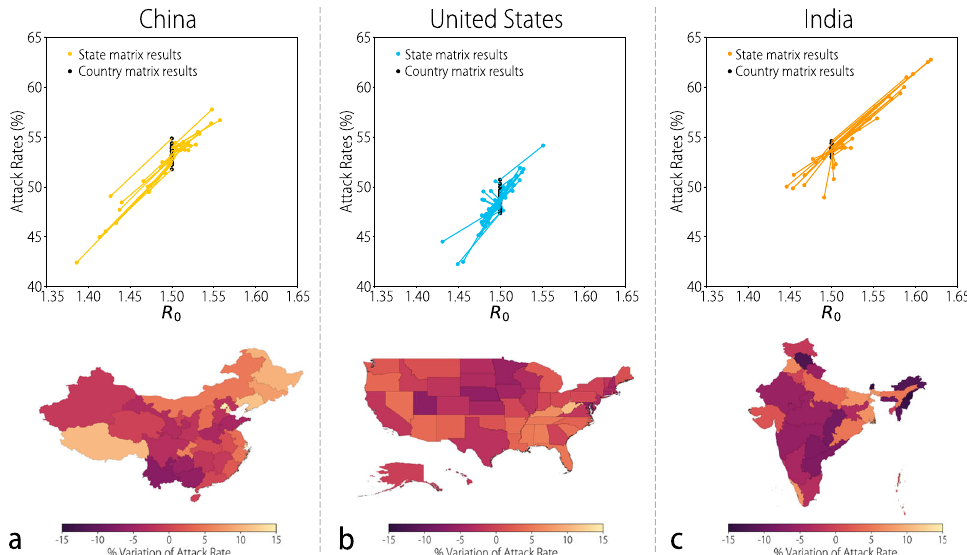
Fig. 7 Subnational heterogeneity. a The black dots represent the estimated attack rates in each province of China by using the country-level contact matrix and the location-speci fi c age structure of the population. Colored dots represent the estimated attack rates in each location by using both the location- speci fi c contact matrix and the age structure of the population. The colored lines connect the two estimated values of attack rate for each location. The transmission rate is set such that R 0 = 1.5 when using the country-level matrix. Each map shows the percentage variation of the attack rate using the location-speci fi c contact matrix with respect to using the national contact matrix as a proxy for the subnational contact patterns (i.e., (AR c − AR l )/AR c , where AR c is the attack rate estimated by using the country-level contact matrix, and AR l is that estimated by using the location-speci fi c matrix). Colors toward Astra in the color scale indicate an overestimation of the attack rate in the location when using the country-level contact matrix as a proxy for the subnational contact patterns. Conversely, colors towards grape in the color scale indicate an underestimation of the attack rate in the location when using the country-level matrix as a proxy for the subnational contact patterns. b Same as a , but for the USA. c Same as a , but for